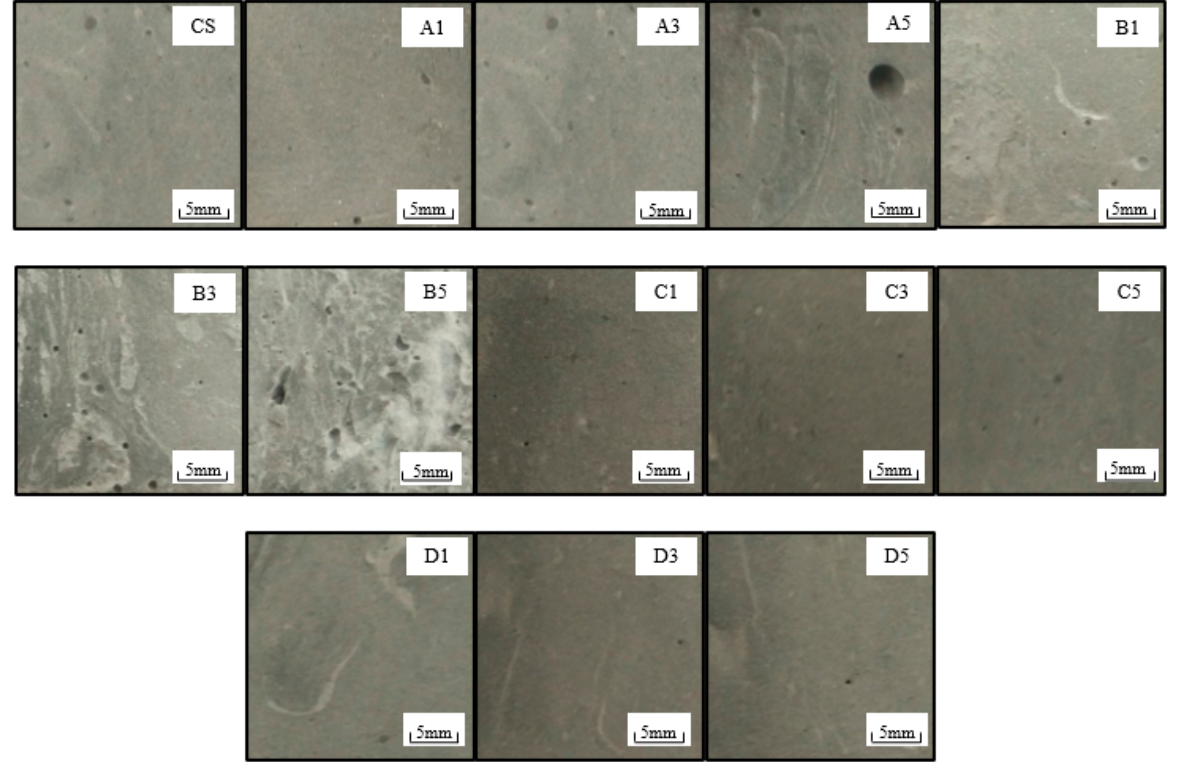
Figure 15. Voids of cement paste section with the calcined NAC.